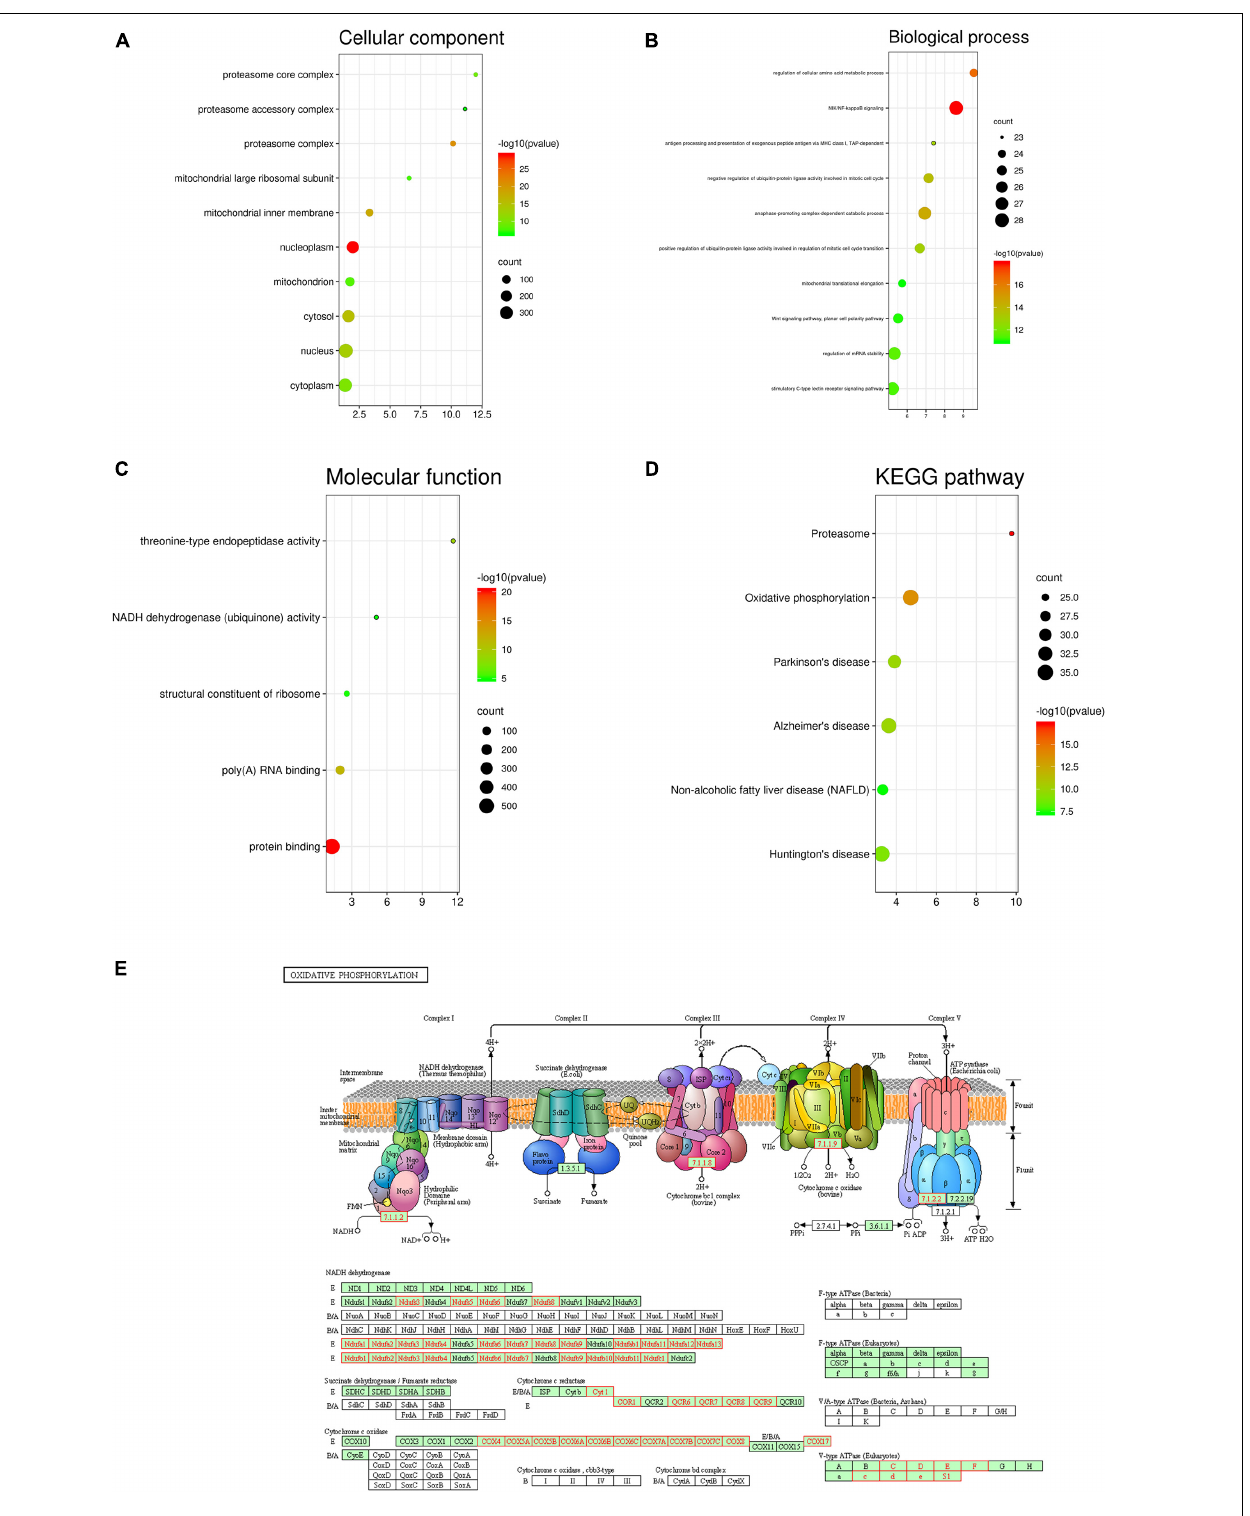
FIGURE 6 | Enrichment analysis of PDZD11 co-expression genes in LIHC. (A–D) The significantly enriched GO annotations and KEGG pathways of PDZD11 co-expression genes in LIHC are analyzed using DAVID. Based on the Pearson test ( Figures 5A–C ), we selected the positively and negatively correlated genes with coefficient > 0.3 and < –0.3 (LinkedOmics and bioinformatics databases). (E) KEGG pathway annotations of the oxidative phosphorylation pathway. Red marked nodes are associated with the Leading Edge Genes. FDR < 0.05 was considered statistically significant.